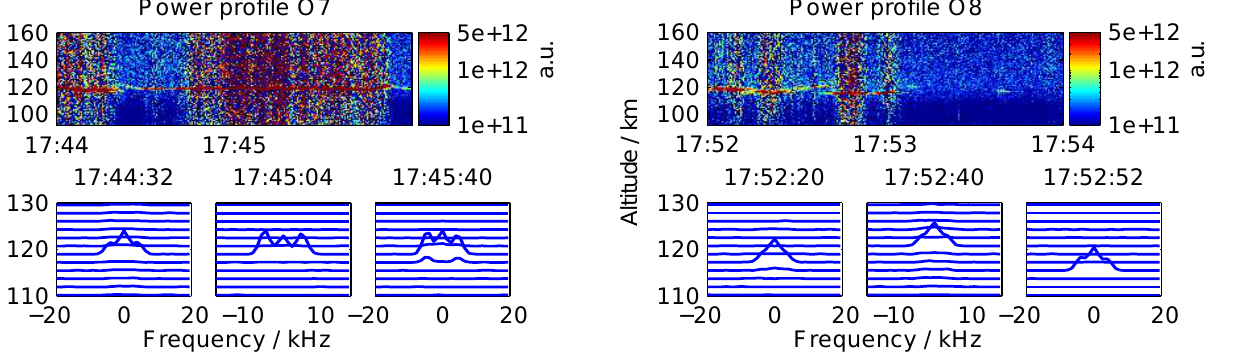
and 17:00:42 and by generally diffuse and weak structures thereafter.